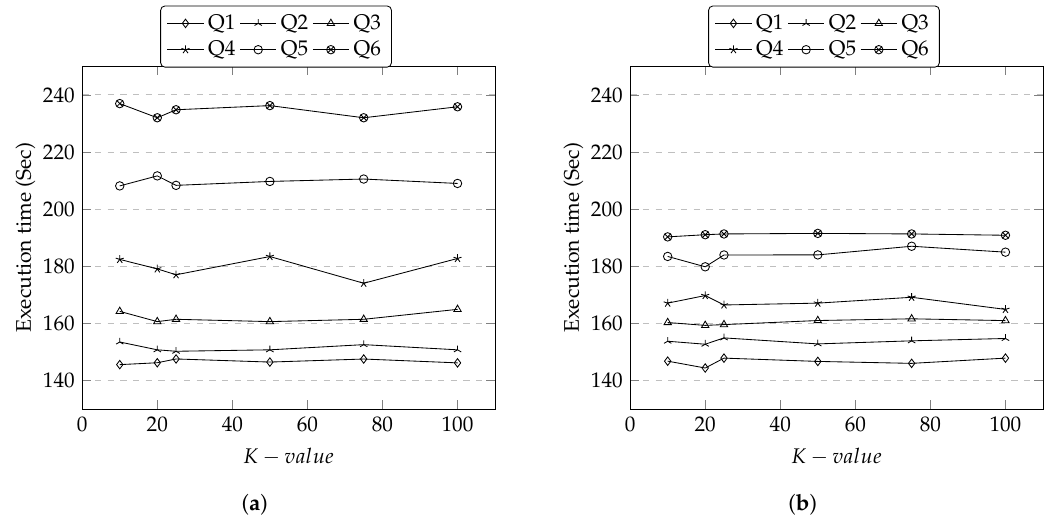
Figure 9. Execution Time vs. QID Size. ( a ) Adult Dataset; ( b ) Irish